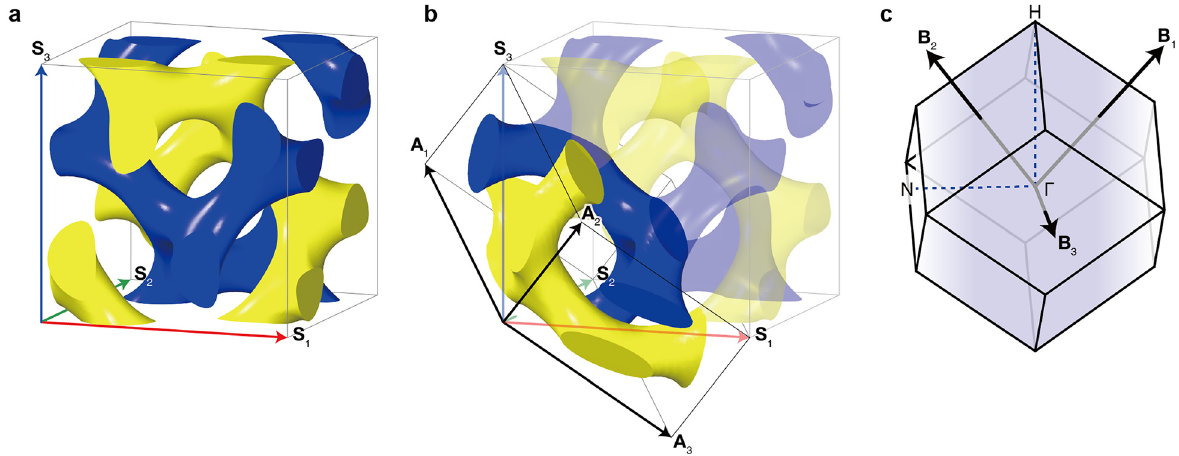
Figure 3: (a) and (b) Double gyroids in conventional and primitive cells, respectively. (c) First Brillouin zone of BCC lattice. High symmetric directions marked here are Γ N = (1/2)( − B 1 + B 2 ) and Γ H = (1/2)( B 1 + B 2 − B